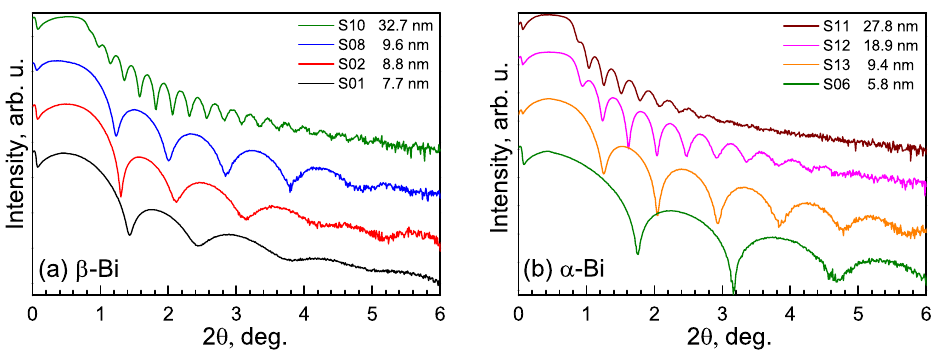
Figure 1. The X-ray reflectivity curves of β -Bi ( a ) and α -Bi ( b ) samples. The structure and crystalline orientations of Bi samples were analyzed by using XRD out-of-plane ω /2 θ and in-plane 2 θχ / φ measurements. The two main surface orienta- tions of rhombohedral bismuth, β -Bi and α -Bi and their in-plane relation to the substrate crystallographic axes were